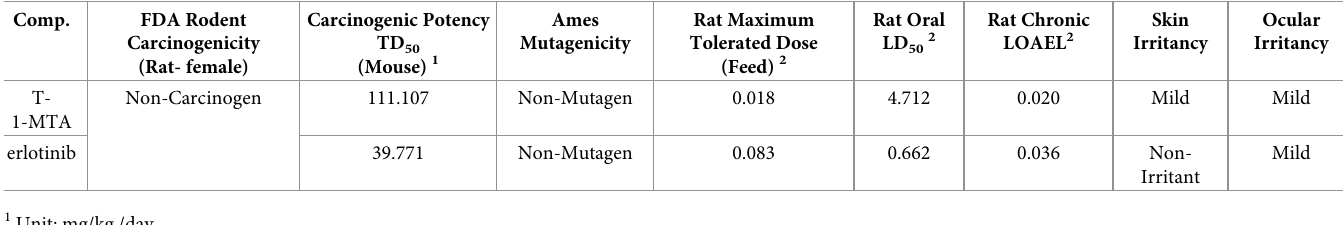
Table 4. In silico toxicity studies of T-1-MTA and erlotinib.